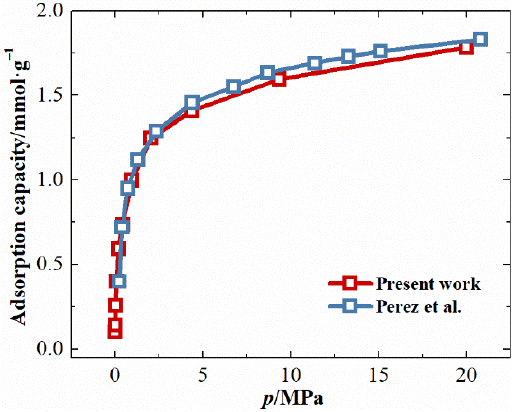
Figure 3. Adsorption isotherm of the kerogen box [34].